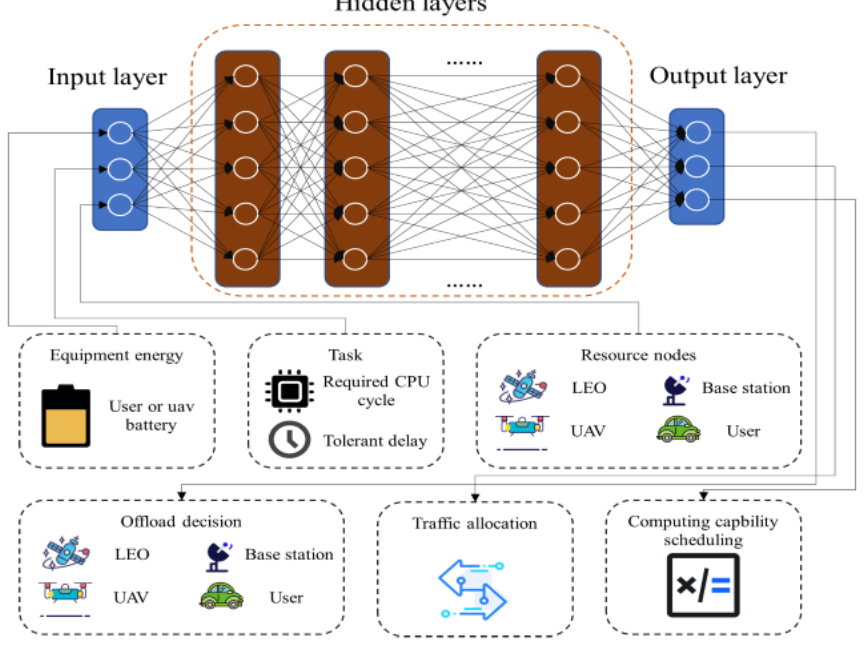
Figure 3. Neural network process flow in